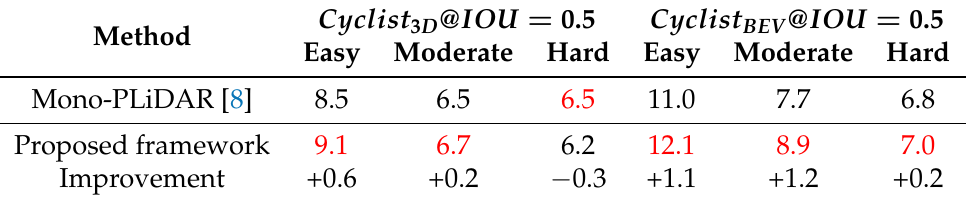
Table 5. Performance of 3D detection of the “cyclist” category of the KITTI validation subset. We indicate the highest results with